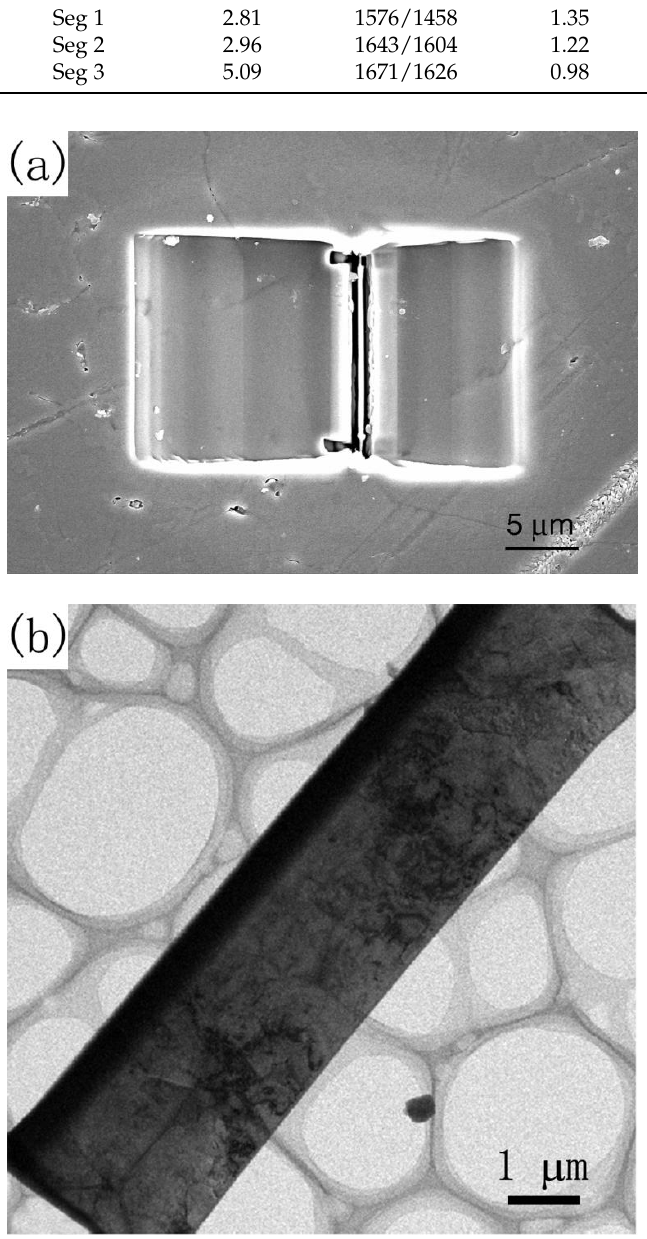
Figure 1. The studied TEM foil cut with an FIB in the polycrystalline olivine sample deformed by the D-DIA (D0966). ( a ) An SEM image showing the foil from an edge-on point of view (middle of the image). ( b ) A TEM image of the foil showing mottled contrast, indicating abundant